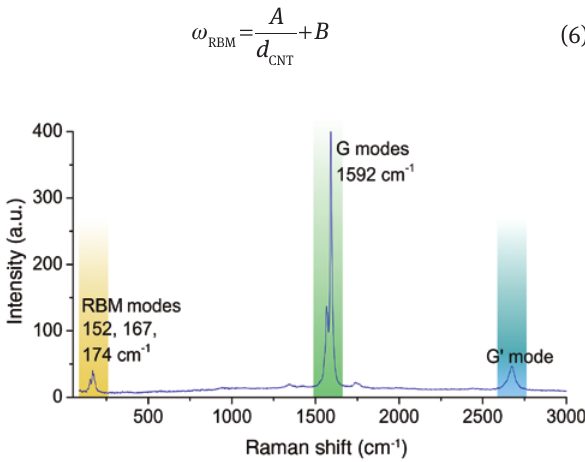
Figure 6: Example of Raman spectrum of CMC/SWNT polymer film. The spectrum shows doublet G mode at 1592 cm -1 and RBM at 152, 167 and 174 cm -1